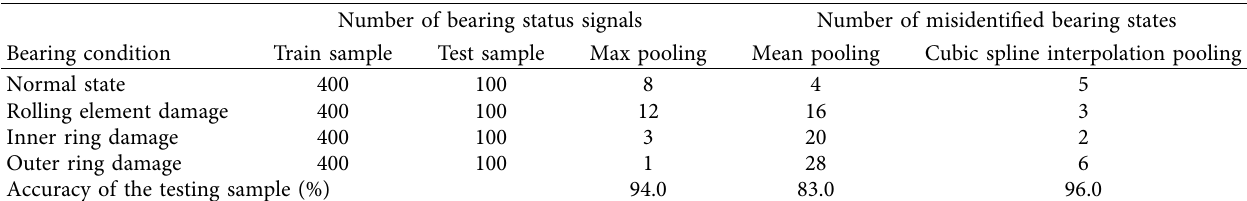
Figure 10: Time-domain waveforms of the four types of bearing signals. (a) Normal state. (b) Rolling element damage. (c) Inner ring damage. (d) Outer ring damage. Table 1: Results of the